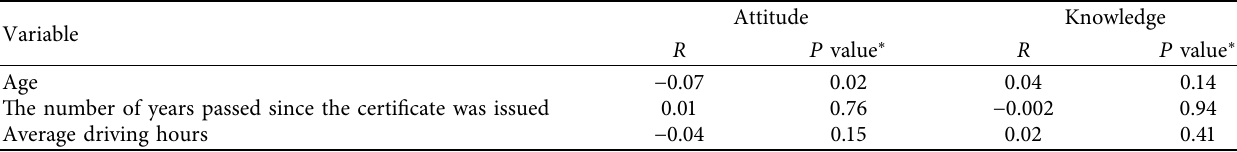
Table 3: Determining the relationship between variables (age, average years of passage of certifcate, and number of driving hours) with mean score of knowledge and attitude.